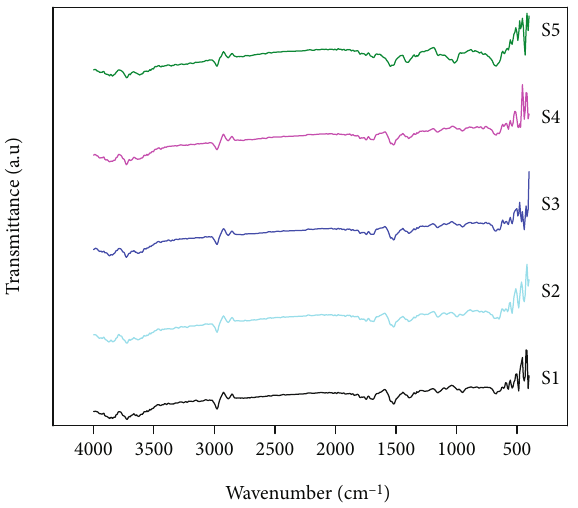
Figure 2: FTIR spectrum of PUL-CMC blend fi lms (S1-100/0, S2-75/25, S3-50/50, S4-25/75, and